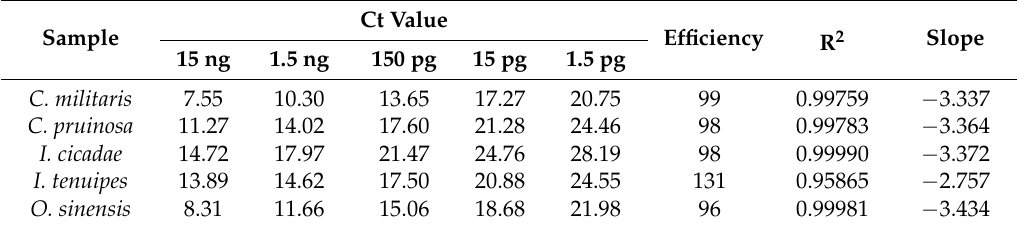
Table 4. The sensitivities, efficiencies, and correlation coefficients of the real-time PCR assays. Ct Value Sample